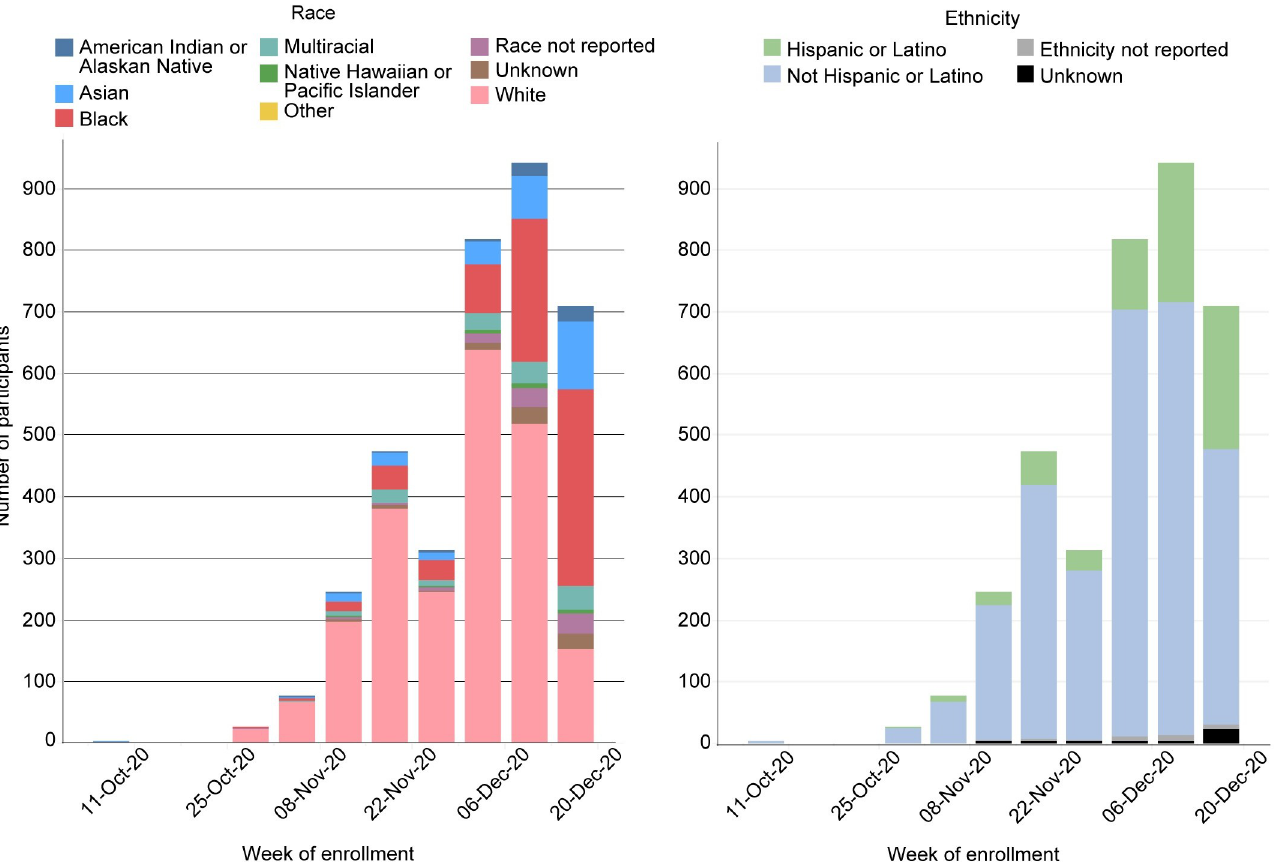
Fig 4. J&J (ensemble study) enrollment. (A) Counts reflect participants who completed study Day 1 with the intention of